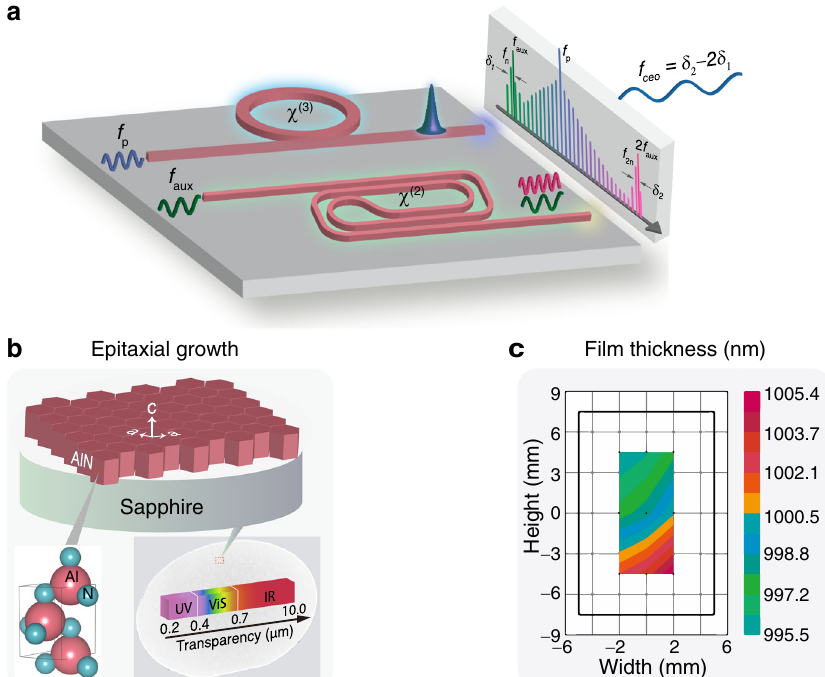
Fig. 1 Experimental scheme. a Illustration of f – 2 f interferometry using octave-spanning soliton microcombs and second-harmonic generators in a nanophotonic platform harboring both χ (3) and χ (2) susceptibilities. The offset frequency f ceo is accessible from the beatnotes of δ 1 and δ 2 , and f p is the pump laser frequency. b Top: sketch of a hexagonal aluminum nitride (AlN) layer (lattice constants: a and c ) epitaxially grown on a c -plane sapphire substrate. Bottom: unit cell of an AlN crystal (left) and photograph image of a 2-inch AlN wafer featuring a broad transparency window from ultraviolet (UV), visible (ViS) to infrared (IR) regimes (right). c Spectroscopic ellipsometer mapping of the AlN fi lm thickness in a region of 4 × 9 mm 2 , showing a minor variation of 1000 ± 5 nm denoted by the right color